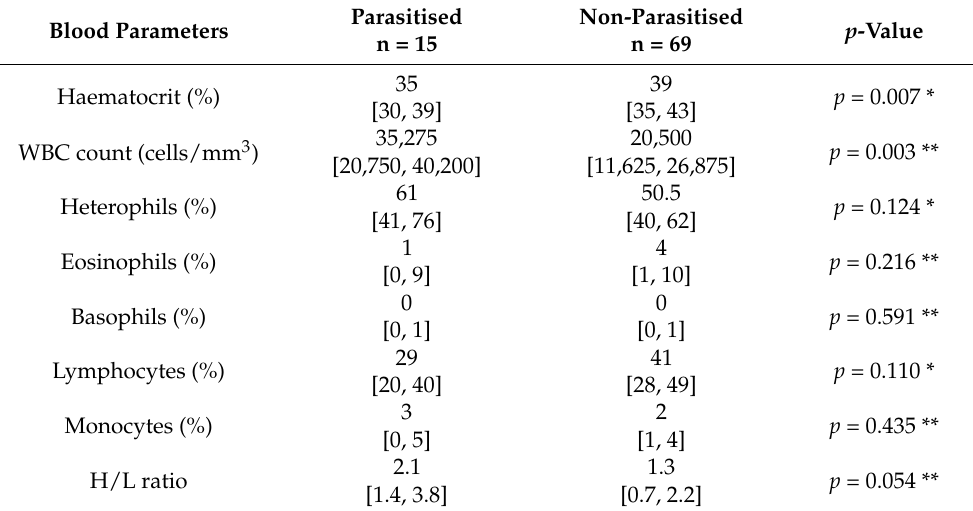
Table 3. Comparison of hematological parameters between parasitized and non-parasitized barn owls using Student’s t -test or Mann–Whitney test. Results are expressed with median and quartiles [Q1,